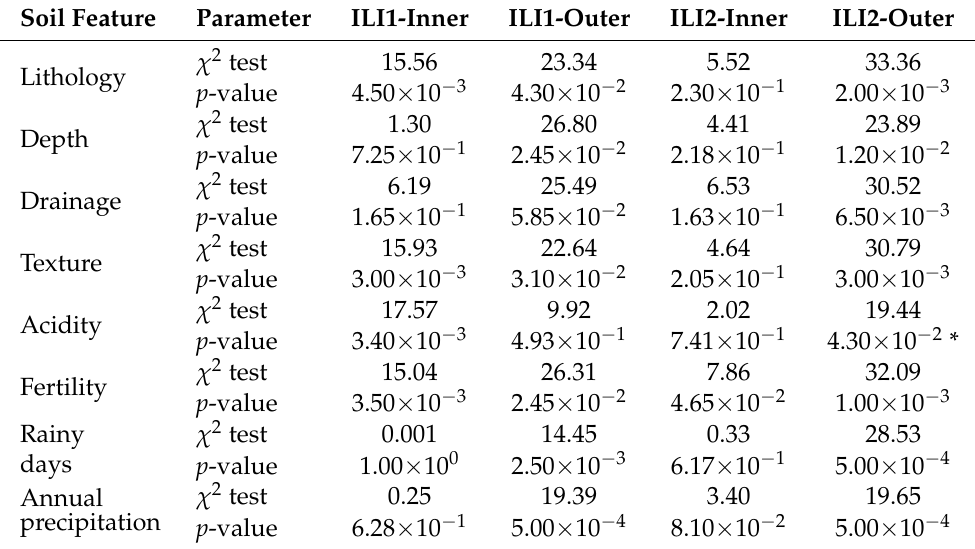
Table 6. Chi-squared test results for the soil features